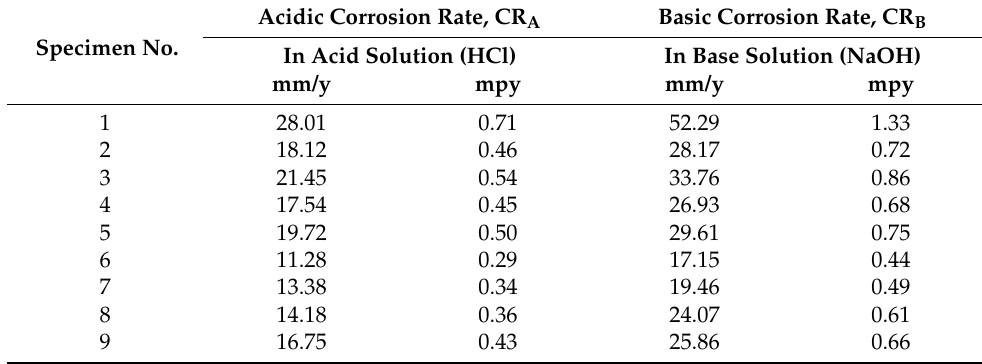
Table 7. Immersion corrosion test results.